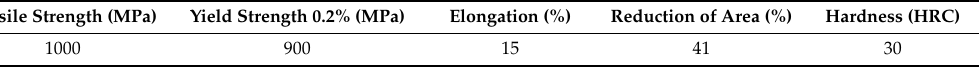
Table 2. Physical properties of Ti-6Al-4V titanium alloy.